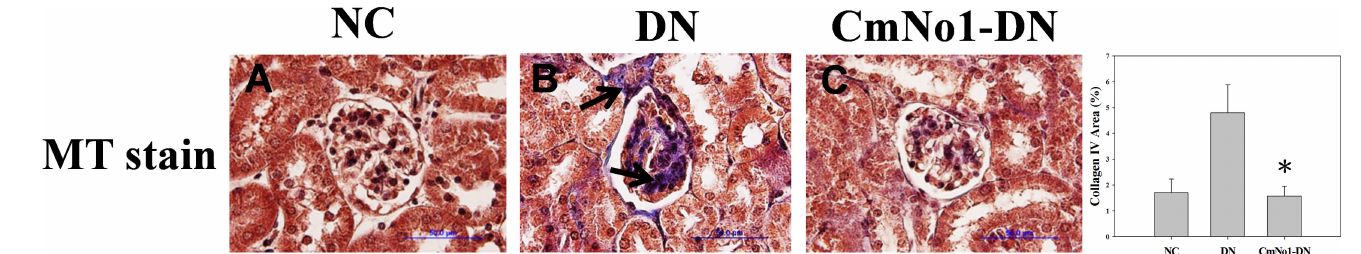
Fig 6. Effect of CmNo1 on collagenous deposition. Representative microphotographsof kidney sections of NC, DN and CmNo1-DNgroup mice subjectedto MT (A-C, × 1000)stain. NC: Normal control; DN: Diabeticnephropathy; CmNo1-DN: Diabeticnephropathygroup mice treated with Cordycepsmilitaris No1; MT, Masson trichrome.